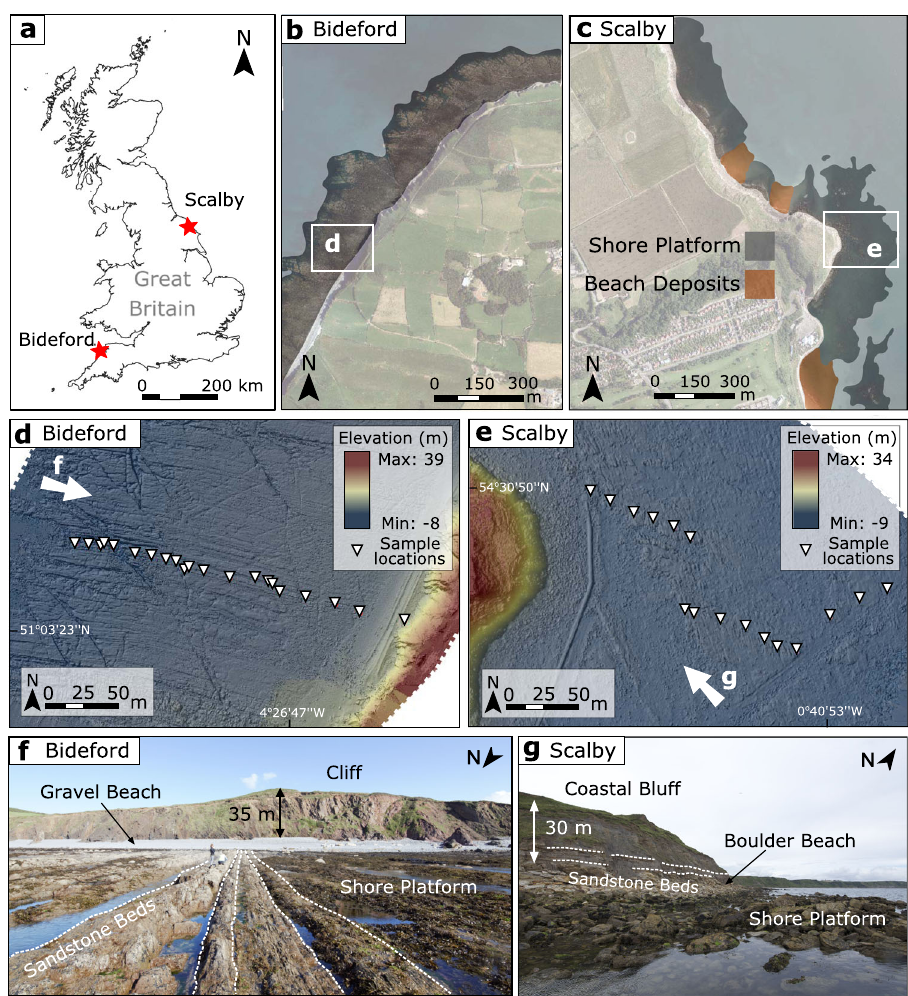
Fig.1|Studysites.a MapofGreatBritainwithsiteslocated. b Bidefordsamplesite locationwithaerialimageryandlocationofshoreplatformshown. c Scalbysample site location with aerial imagery and location of shore platform shown. d Bideford shaded relief digital surface model (DSM) and cosmogenic radionuclide (CRN)